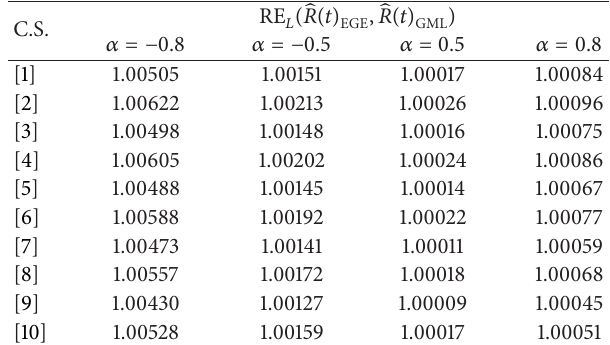
Table 5: Risk efficiency of GELF for different values of 𝛼 .